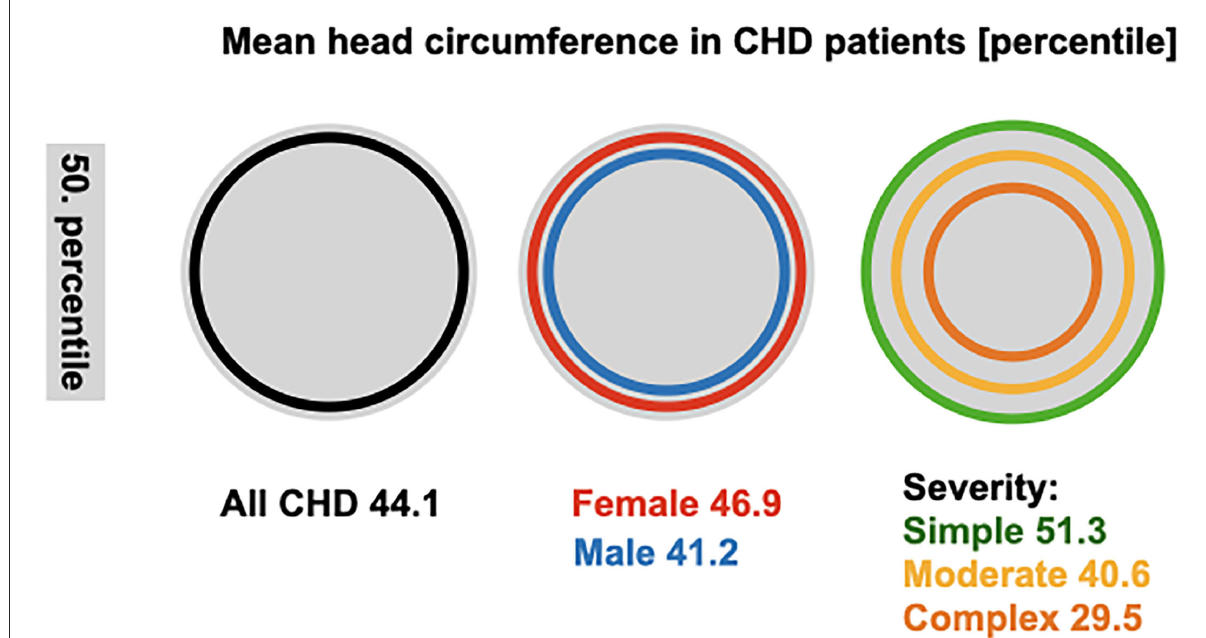
FIGURE1 Mean head circumference in CHD patients. Head circumference percentiles at 3–4 months in all CHD patients and subgroups. The gray circle represents the 50 percentile, and data of patients and subgroups are denoted as the mean. SD for all, sex and simple severity are 33, moderate severity 32, and complex